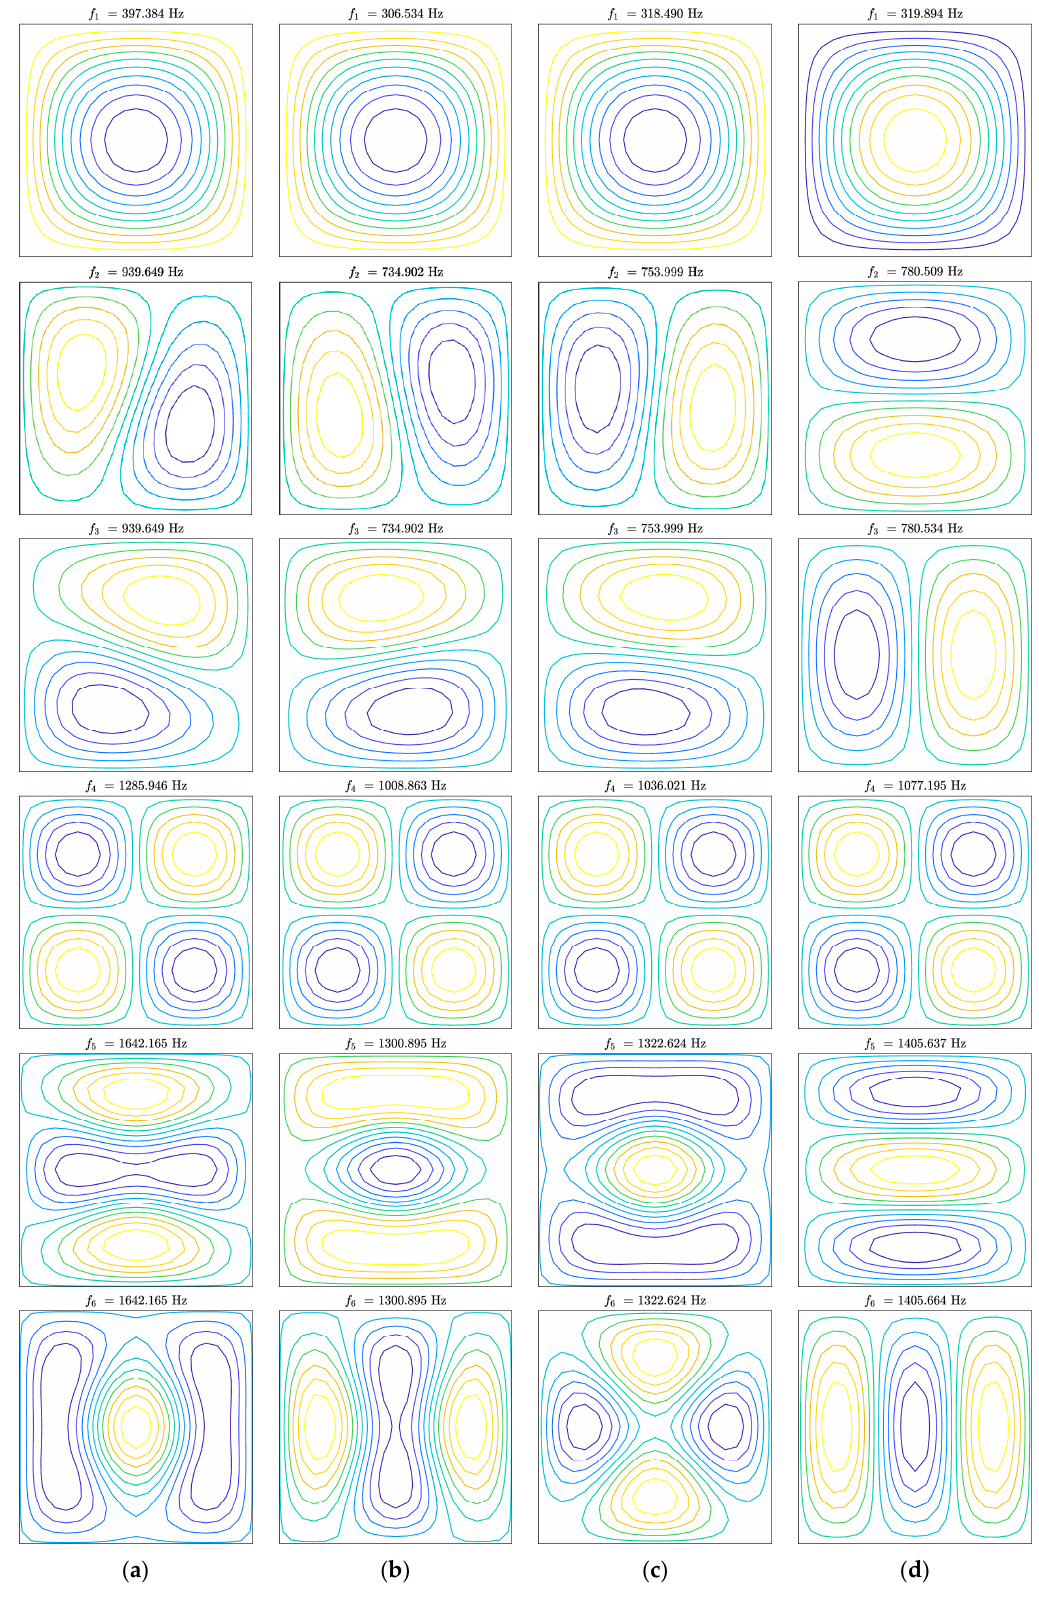
Figure 6. First six mode shapes for a simply-supported laminated thick plate with different fiber distributions: ( a ) Scheme 1 (uniform); ( b ) Scheme 2; ( c ) Scheme 3; ( d ) Scheme 4.